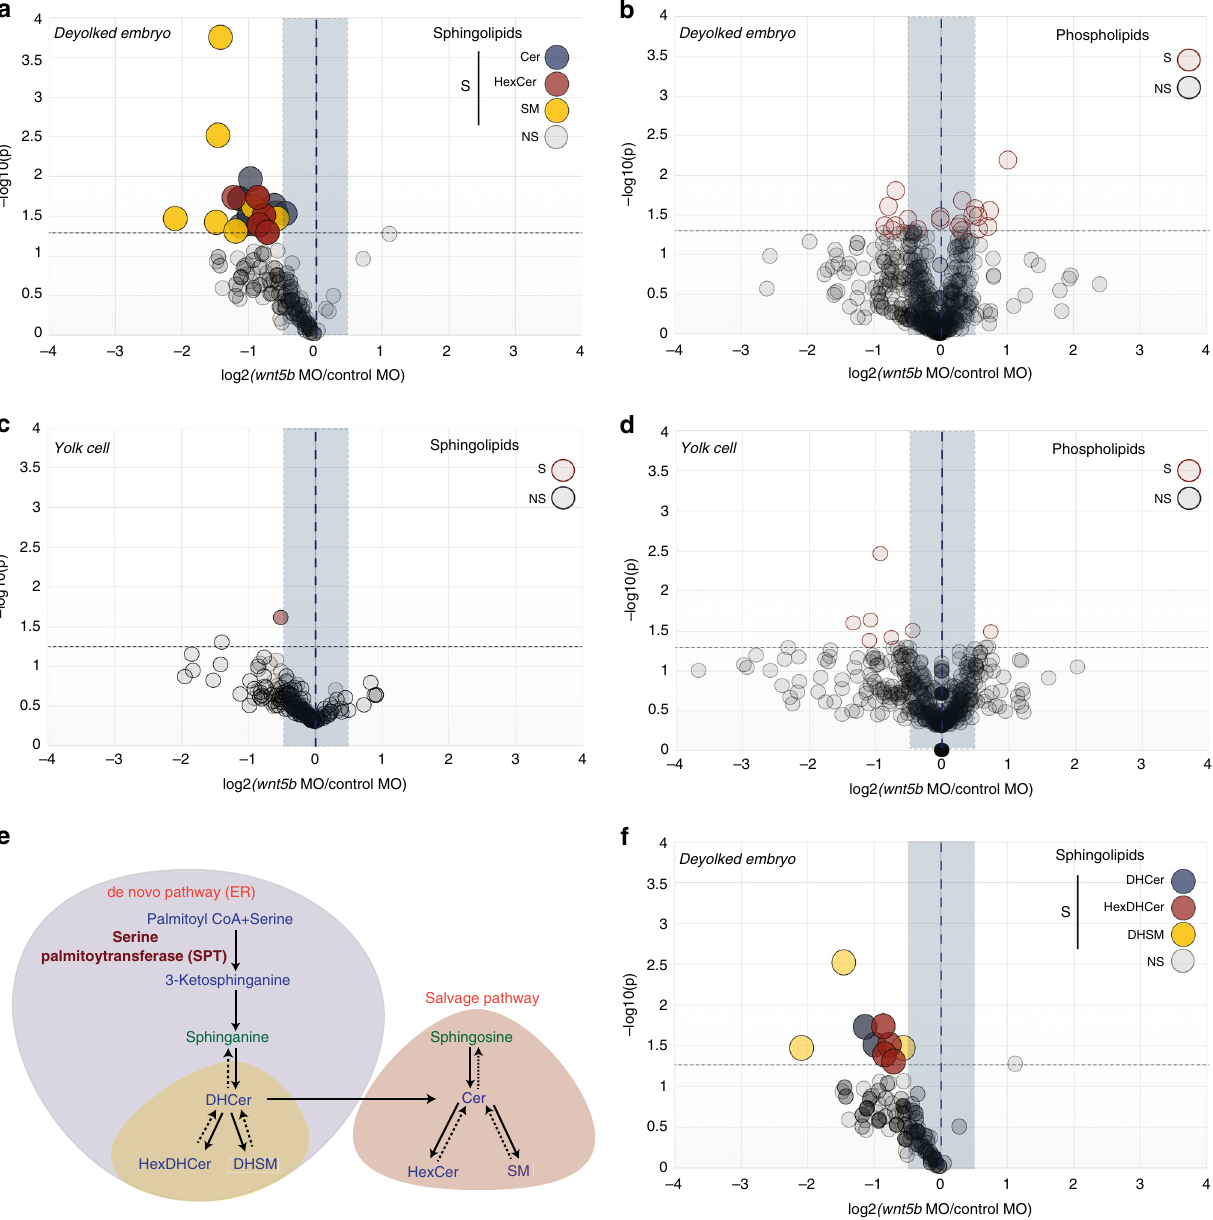
Fig. 1 Wnt5b regulates sphingolipid levels in zebra fi sh embryos. a – d , f Volcano plots of lipidomic data for wnt5b morphants compared to control embryos at gastrula stage (6hpf at 28 °C) from four independent experiments. Horizontal dashed line thresholds signi fi cance ( p -value = 0.05). NS (statistically non- signi fi cant); S (statistically signi fi cant). Unpaired, two-tailed student ’ s t -test was used. Blue shadowed area delimits + / − 1.5-fold difference in abundance with respect to control. Relevant changes in the decrease of the content of a lipid species are located in the upper left quadrant. Each dot corresponds to an individual lipid species. a , c Sphingolipids in deyolked wnt5b morphant embryos ( a ) or in the yolk cell of wnt5b MO-injected embryos ( c ). Blue dots correspond to ceramides (Cer), red to Hexosylceramides (HexCer) and yellow to sphingomyelin (SM). b , d Phospholipids (PC, PE, PI, and PS) in deyolked wnt5b morphant embryos ( b ) or in the yolk cell of wnt5b MO-injected embryos ( d ). Note that the phospholipids signi fi cantly downregulated or upregulated beyond 1.5-fold in b and d correspond to phospholipids present at very low levels (between 1.3 x 10 − 3 and 8.4 x 10 − 7 Mol%) and therefore their amounts cannot be precisely determined in control versus wnt5b morphant conditions. e Simpli fi ed scheme representing both the de novo and salvage pathways for sphingolipid biosynthesis, with selected metabolites and genes indicated. DHCer dihydroceramide, HexDHCer dihydrohexosylceramide, DHSM dihydrosphingomyelin. f Volcano plot for sphingolipids in the de novo pathway in wnt5b deyolked morphant embryos. Lipid amounts are normalized as pmol/nmol inorganic phosphate (see “ Methods ” ). Source data are provided as a Source Data fi